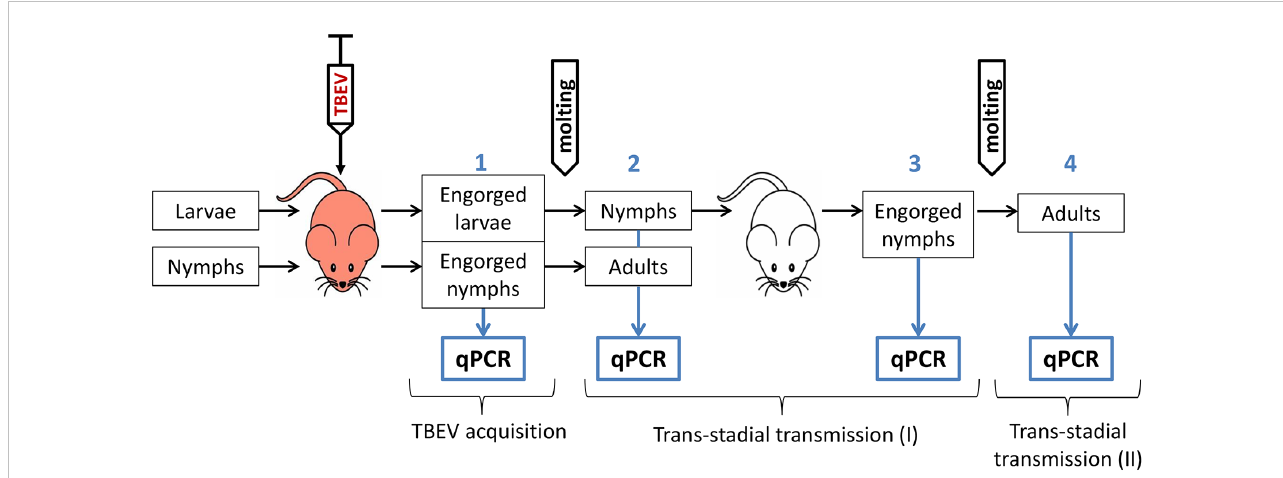
FIGURE 1 Schematic illustration of the experiment regarding TBEV transmission in Ixodes ricinus, Ixodes persulcatus ticks and their hybrids. Red mouse — TBEV- infected mice, white mouse — uninfected mice, qPCR — quantitative PCR. Blue numbers indicate different stages of the